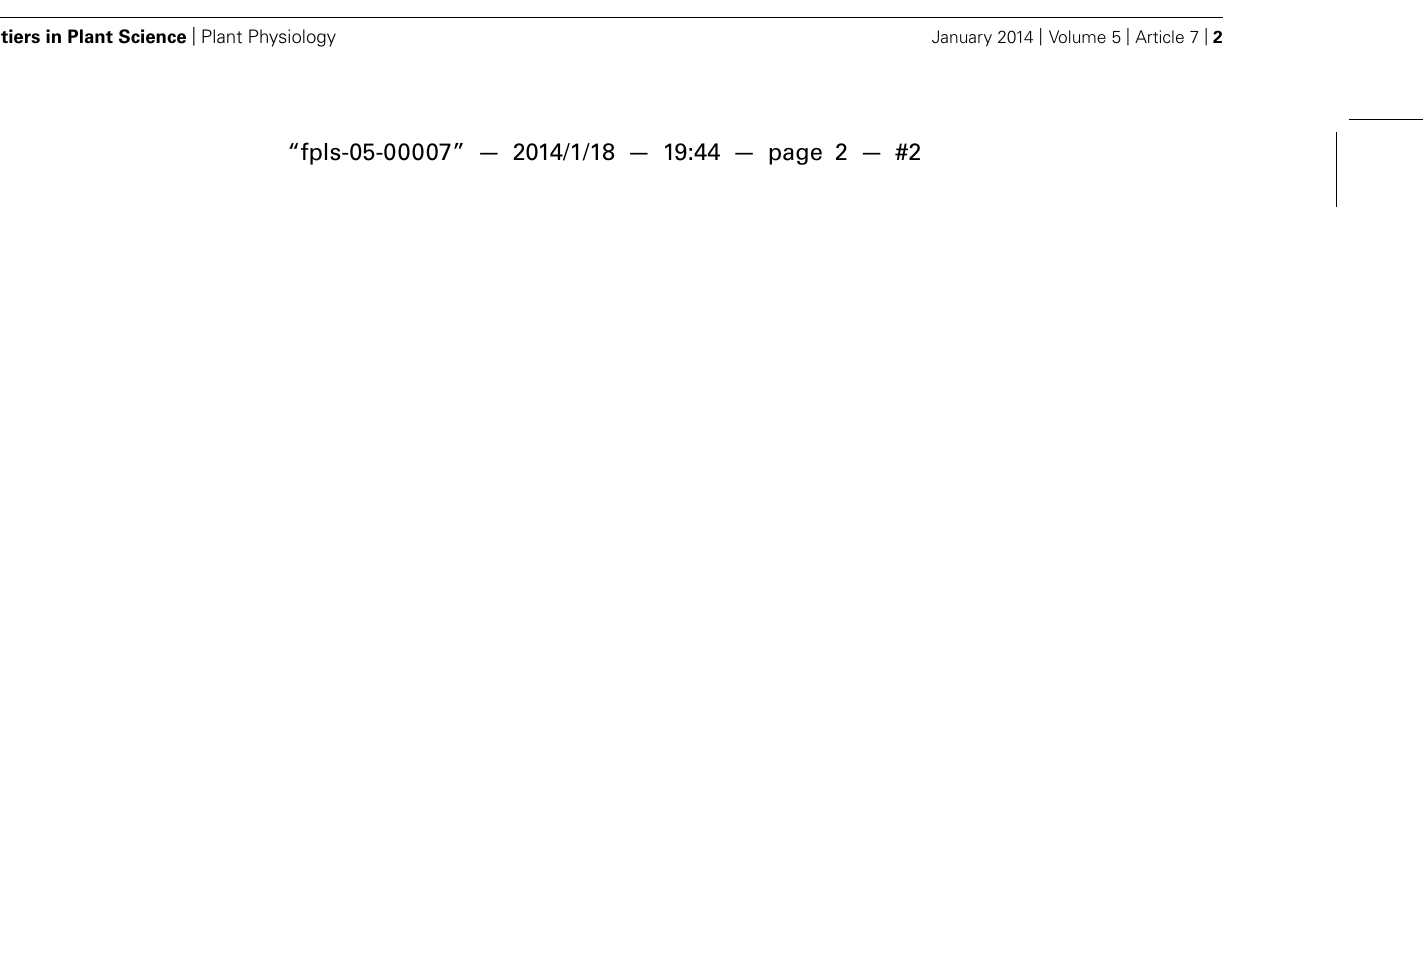
is unknown (Zhang etal., 2012). See text for further discussion and references. Flv, Flavodiiron protein; FNR, ferredoxin-NADP oxidoreductase; Hox, bidirectional [NiFe] hydrogenase; OCP, orange carotenoid protein; pmf, proton-motive force; PSI, Photosystem I; PSII, Photosystem